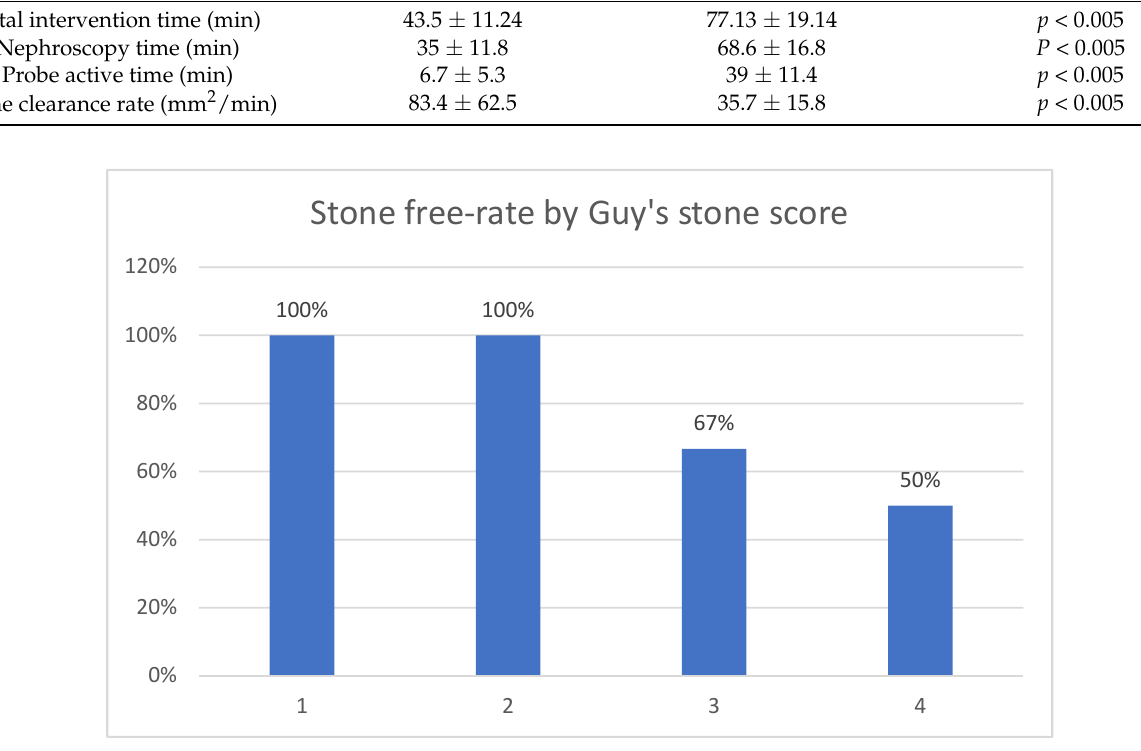
Figure 3. Stone free by Guy’s score in the Trilogy group.